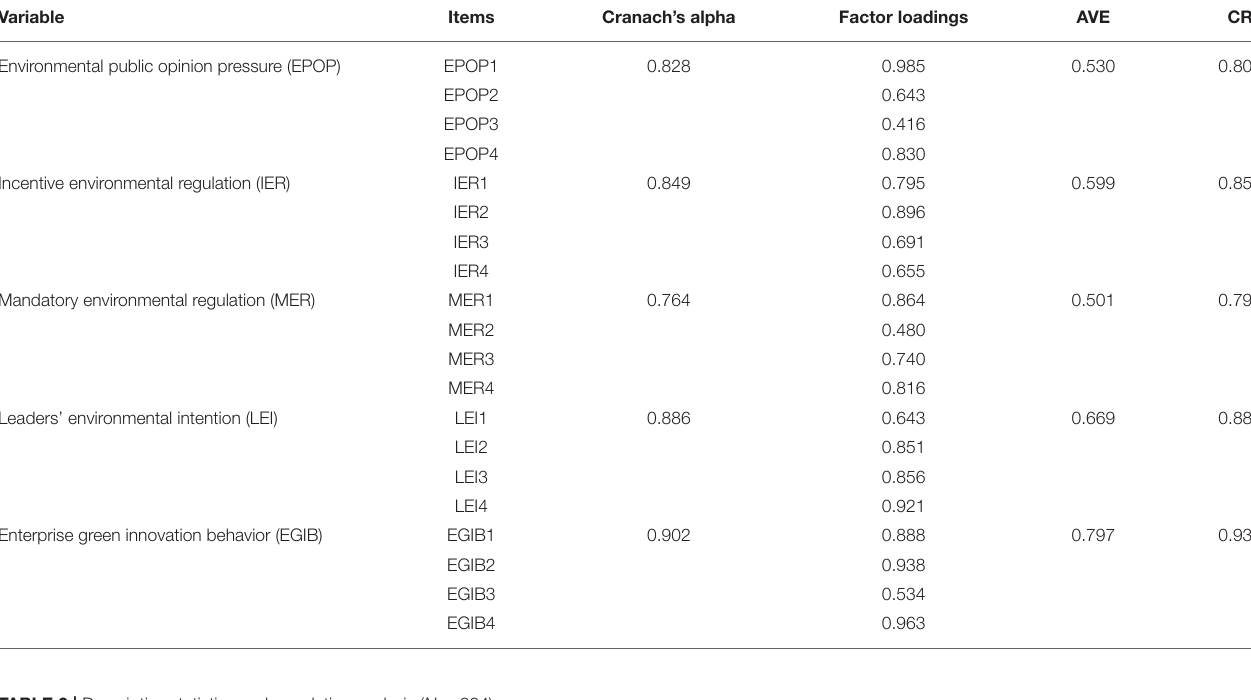
TABLE 1 | Reliability and validity test.